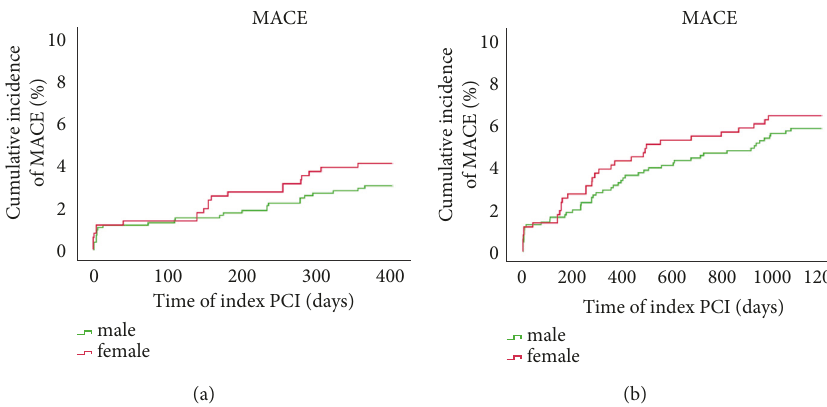
Figure 3: Survival analysis: Kaplan–Meier curves for MACE at one year (a) and three years (b) comparing males and females with PCAD.